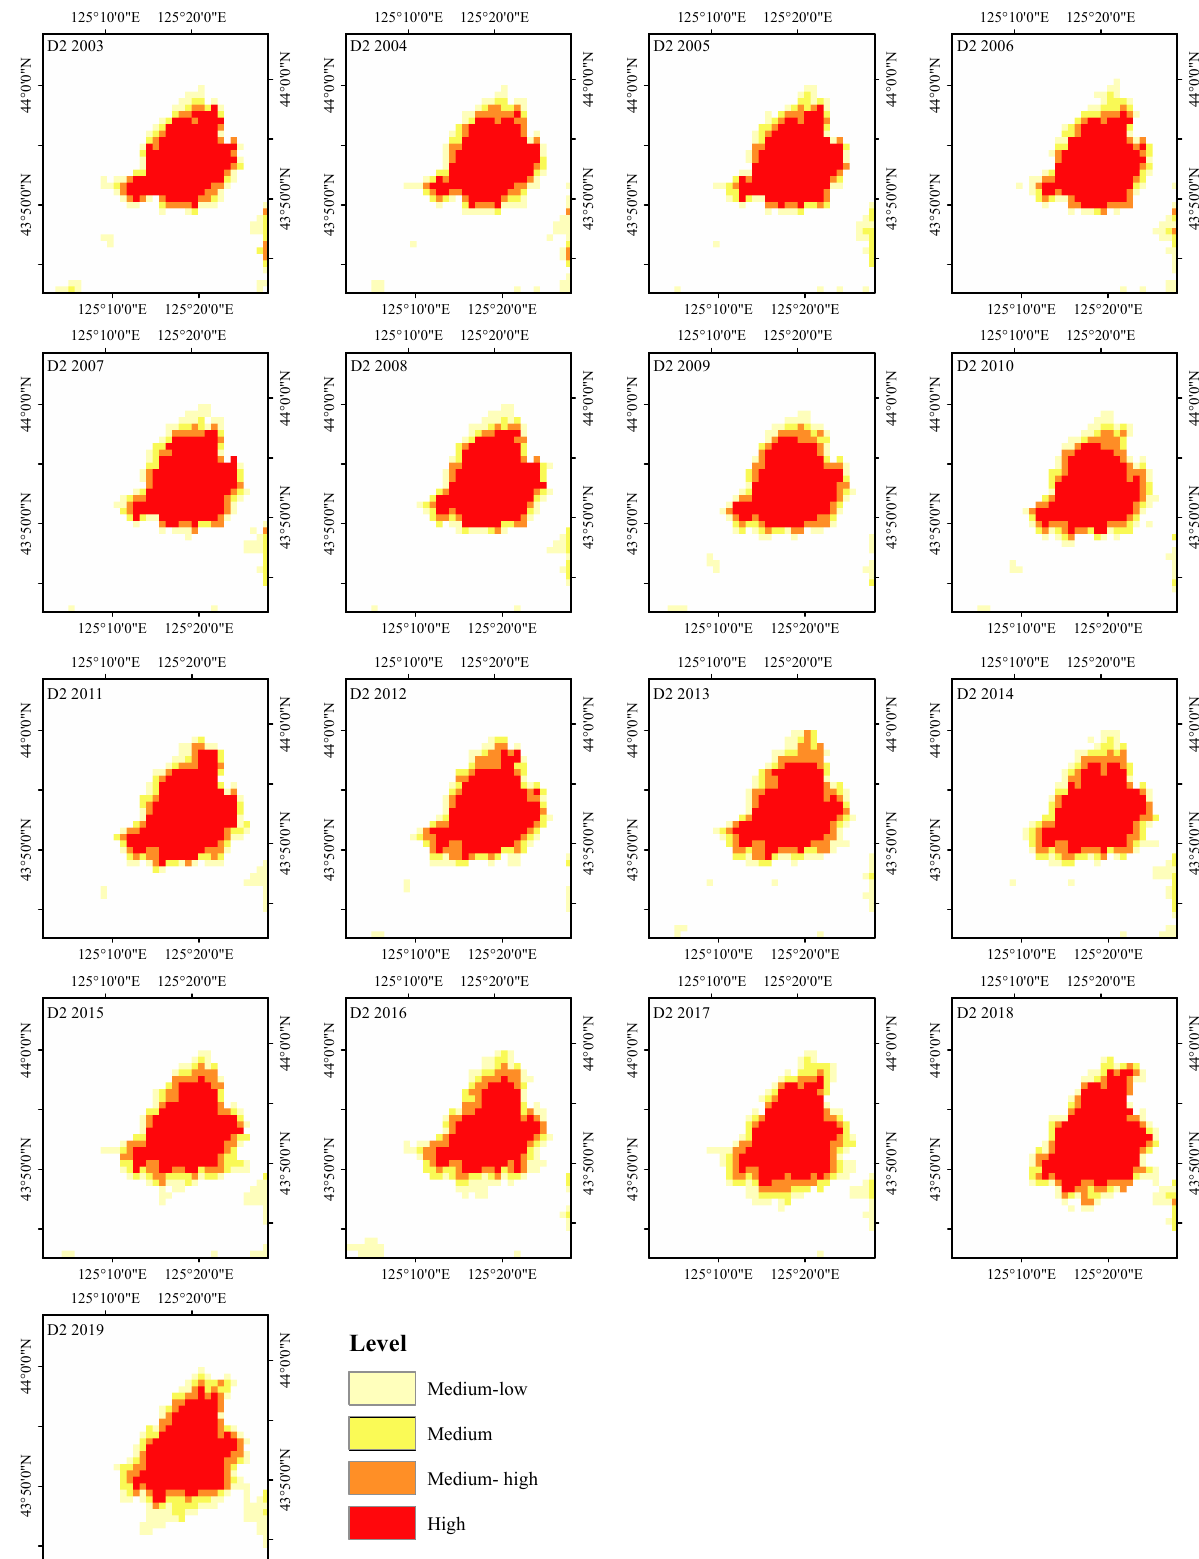
Figure 8. Equivalent heat island intensity (EHII) changes from 2003 to 2019 in D1.